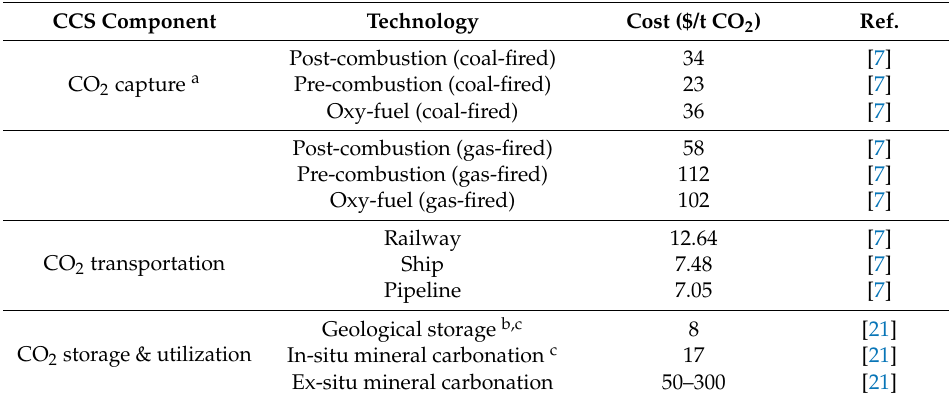
Table 2. The current cost of each CCS